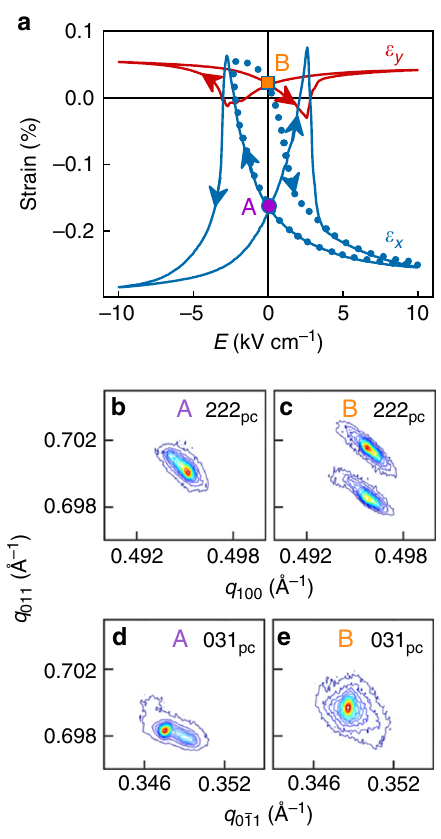
Fig. 2 Electrically driven strain in platinized PMN-PT (011) pc . a In-plane strain components ε x (blue) and ε y (red) versus electric fi eld E , for PMN-PT with x || [100] pc and y || 01 (cid:1) 1 ½ (cid:2) . Remanent states A (purple dot) and B pc (orange square) were achieved via the minor loop shown for ε x (dotted blue line). b – e Reciprocal space maps showing the b , c 222 pc and d , e 031 pc re fl ections for PMN-PT at b , d A and c , e B. Intensity scale runs from purple (low) to red (high). Scattering vector q = (2/ λ )sin( θ ) for Bragg angle θ . Data in a for annealed PMN-PT from the master substrate used for sample A. Data in b – e for sample A. All data were obtained at room temperature. Source data are provided as a Source Data fi le. in state B. The corresponding reciprocal space maps obtained at zero electric fi eld (Fig. 2b – e) show for our sample that the O phase dominated in state A (single 222 pc re fl ection, split 031 pc re fl ection), while the R phase dominated in state B (split 222 pc re fl ection, single 031 pc re fl ection). The resulting structural